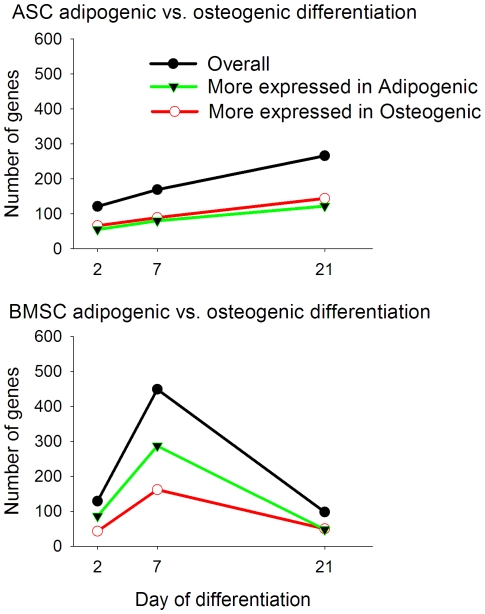
Number of transcripts differentially expressed in adipogenic vs. osteogenic differentiation in ASC and BMSC.The figure reports also the number of genes highly expressed in adipogenic vs. osteogenic differentiation (green line) and osteogenic vs. adipogenic differentiation (red line).